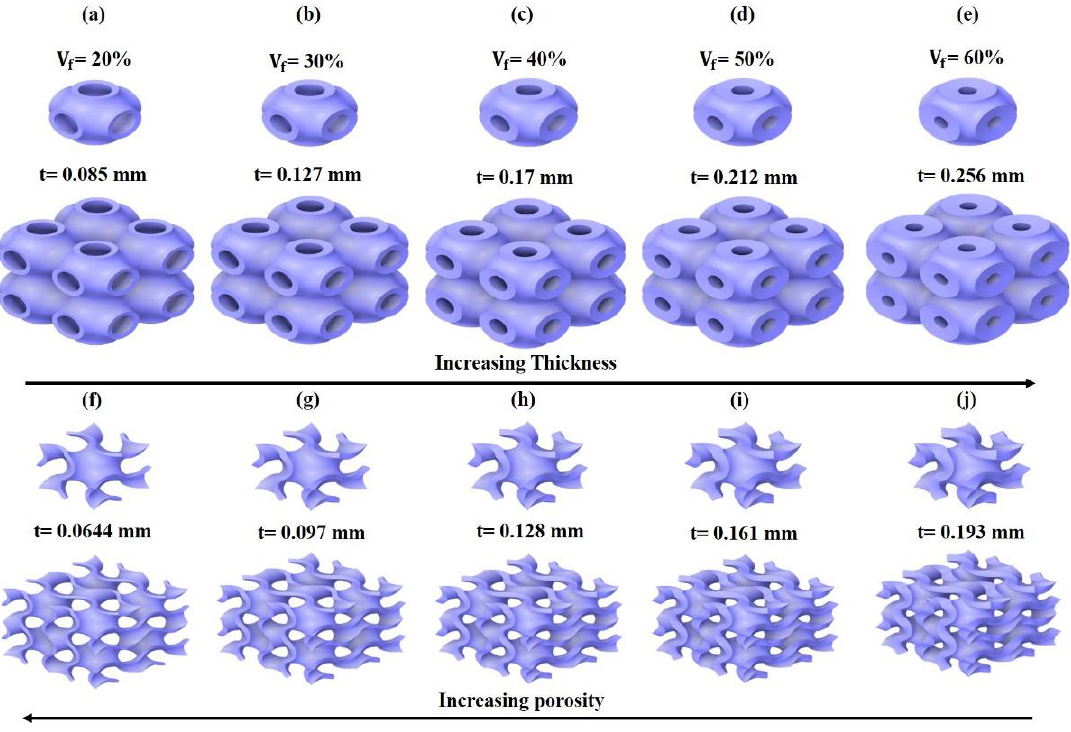
Figure 3. View of the generated unit cell of 1 × 1 × 1 mm 3 and corresponding 2 × 2 × 2 mm 3 lattice cells. ( a – e ) P unit cells in the first row and their corresponding lattice structure in the second row ( f – j ) G unit cells in the third row and their corresponding lattice structure in the fourth row. Represented with an arrow line; the increasing porosity from right to left i.e., 40%, 50%, 60%, 70%, 80%, and from left to right the strut thickness increase for both P and G architectures.